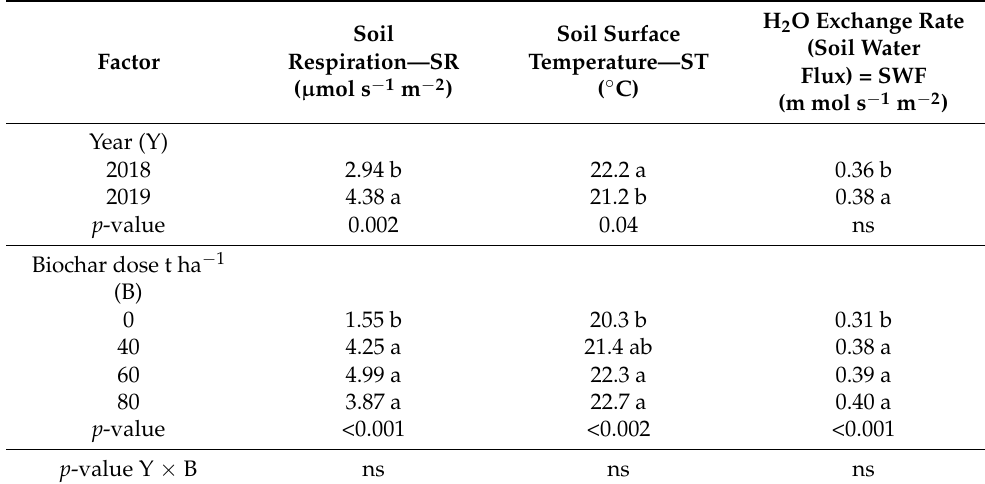
Table 3. Soil respiration, average soil temperature, and water vapor flow in the soil in the studied years (2018–2019), in plots without plants (bare